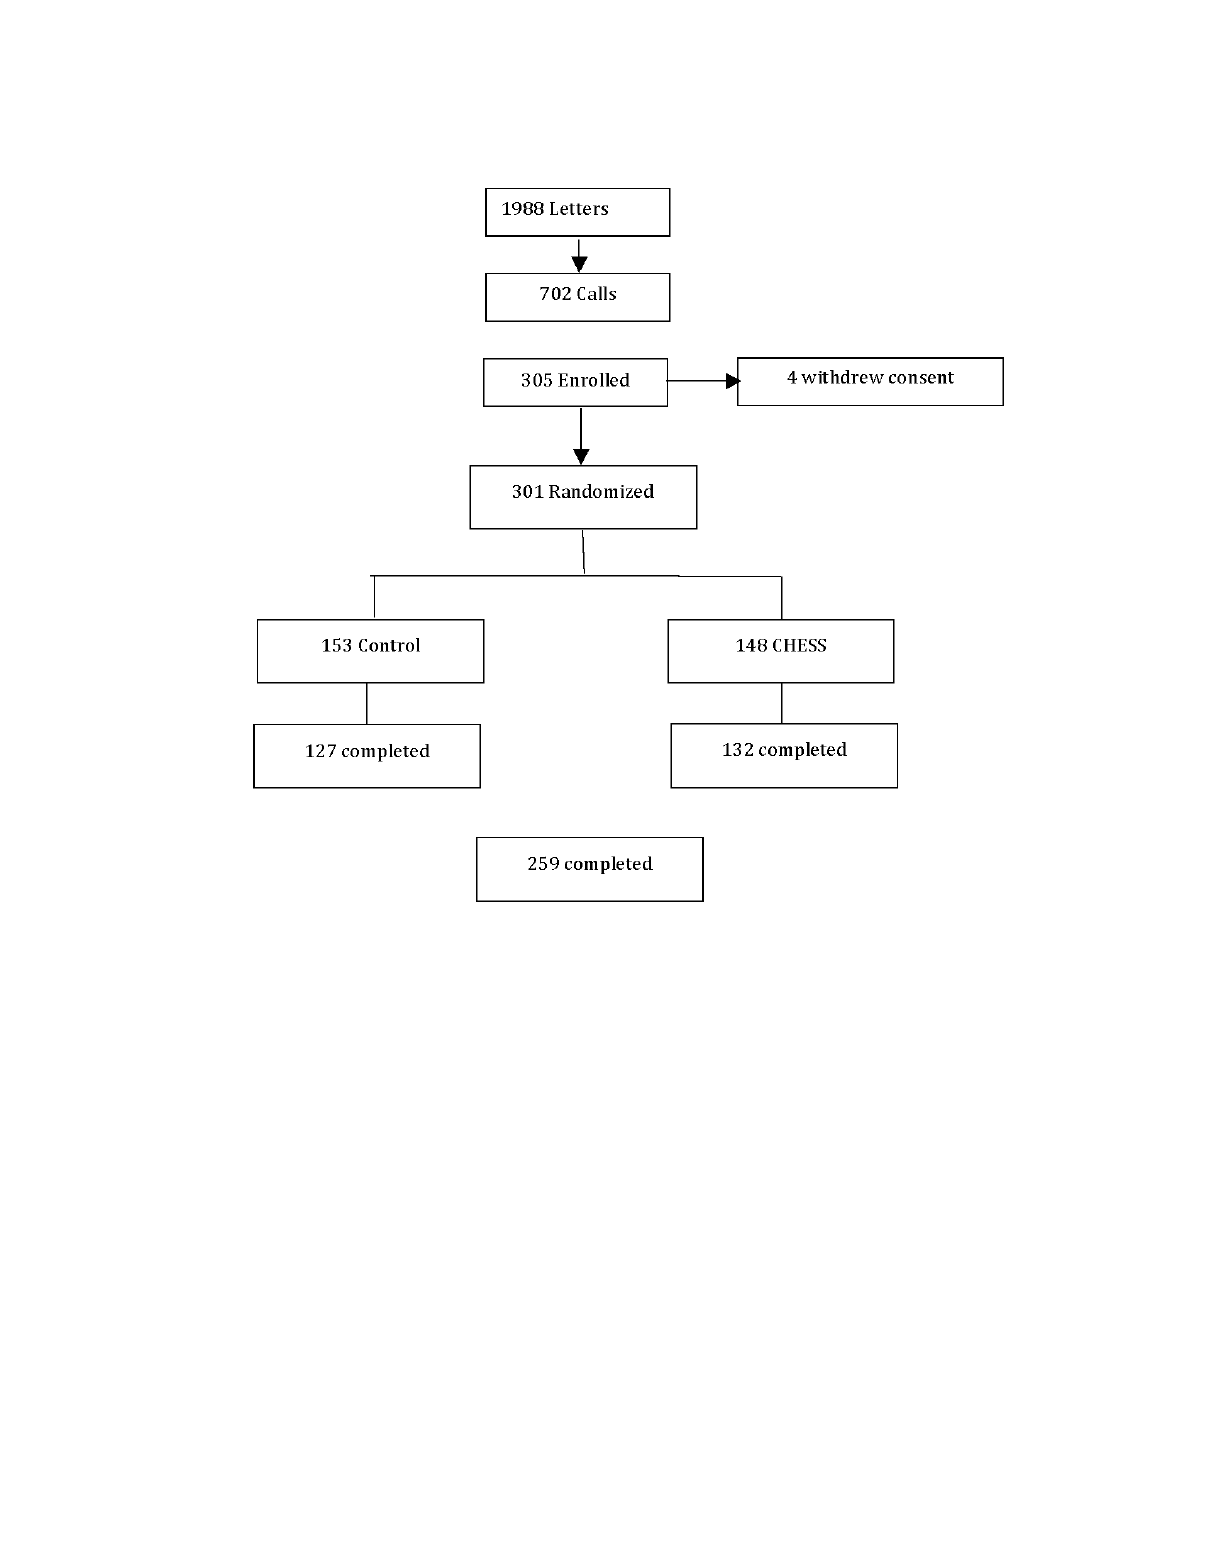
Figure 3. CONSORT diagram of sample pool, recruitment, and